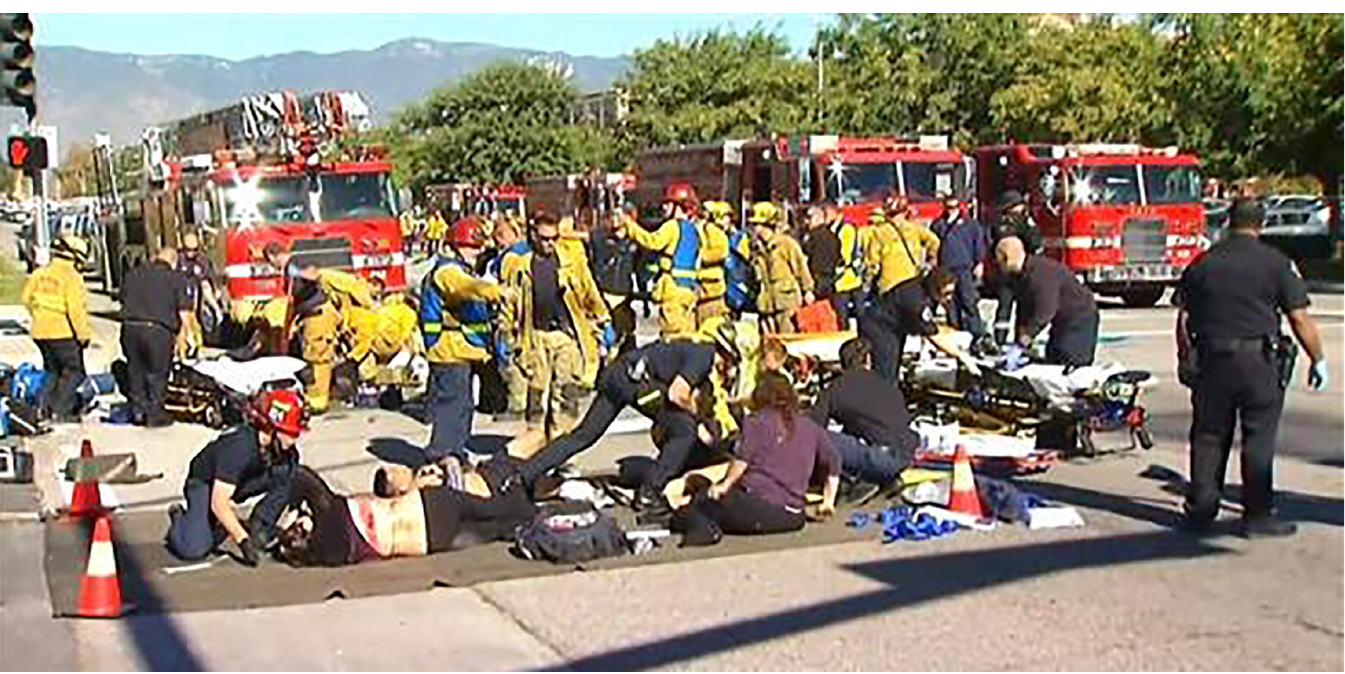
Figure 2. Casualty collection